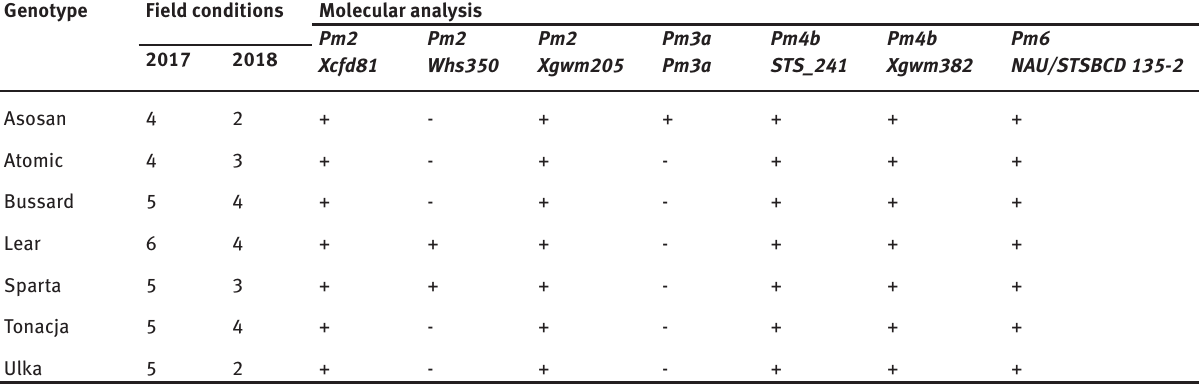
Table 1: The degree of resistance to Puccinia recondita f. sp. tritici infection under field conditions (Dłoń Agricultural Experimental Farm) and the identification of the Pm2 , Pm3a , Pm4b and Pm6 genes by means of molecular markers.